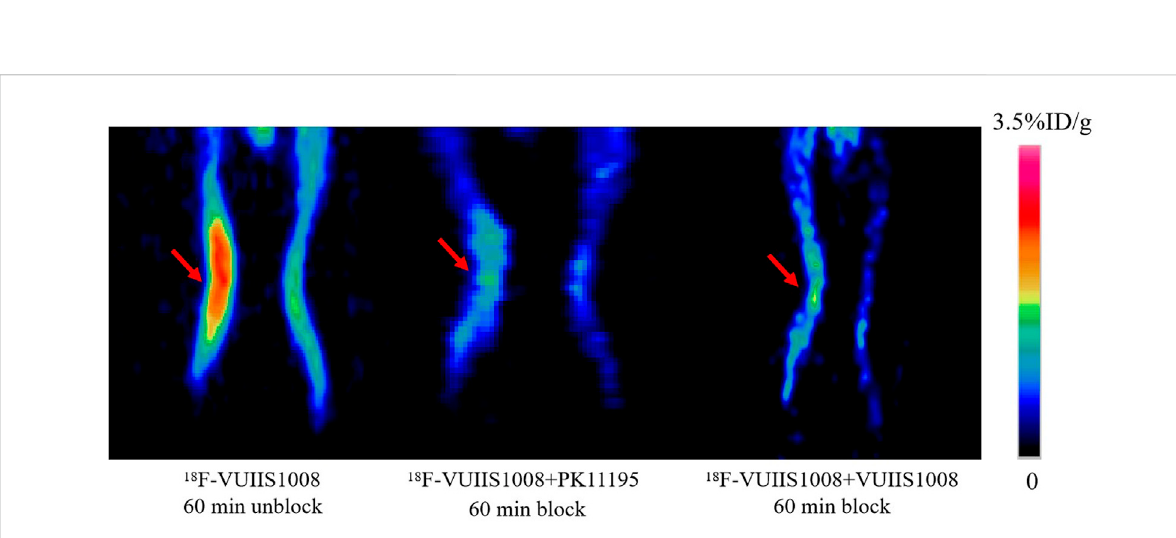
FIGURE 11 Representative PET images of 18 F-VUIIS1008 uptake in the left in fl ammatory ankles without and with cold PK11195 or VUIIS1008 blocking. Red arrow indicate left in fl ammatory ankles.